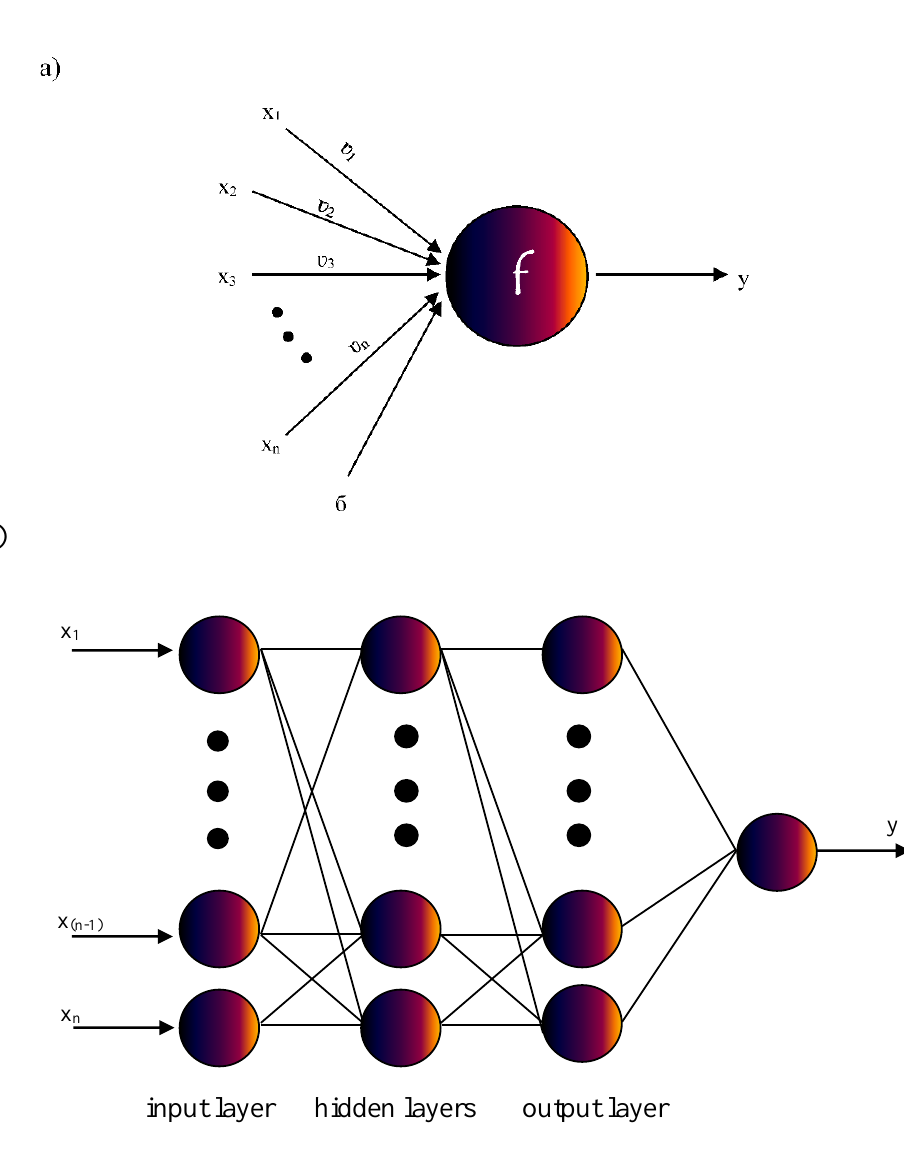
Figure A3. The schematic diagram for an artificial neuron (a) and a neural network (b).